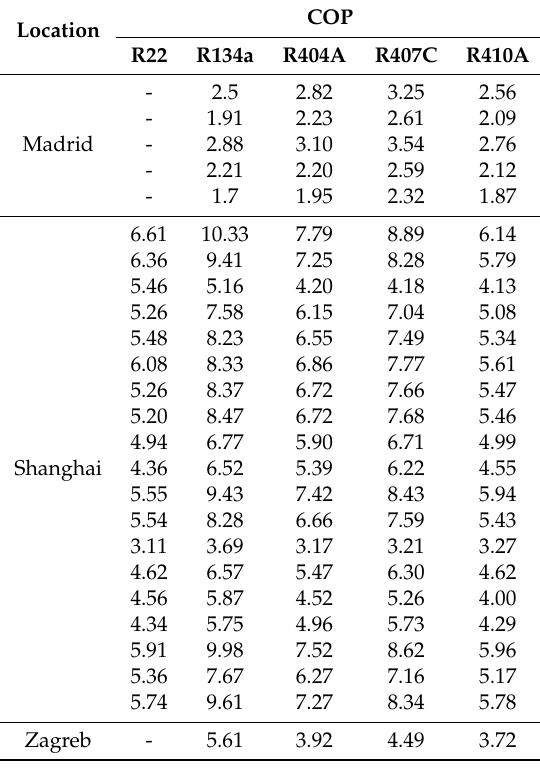
Table 8. Refrigerant selection based on the COP output of the